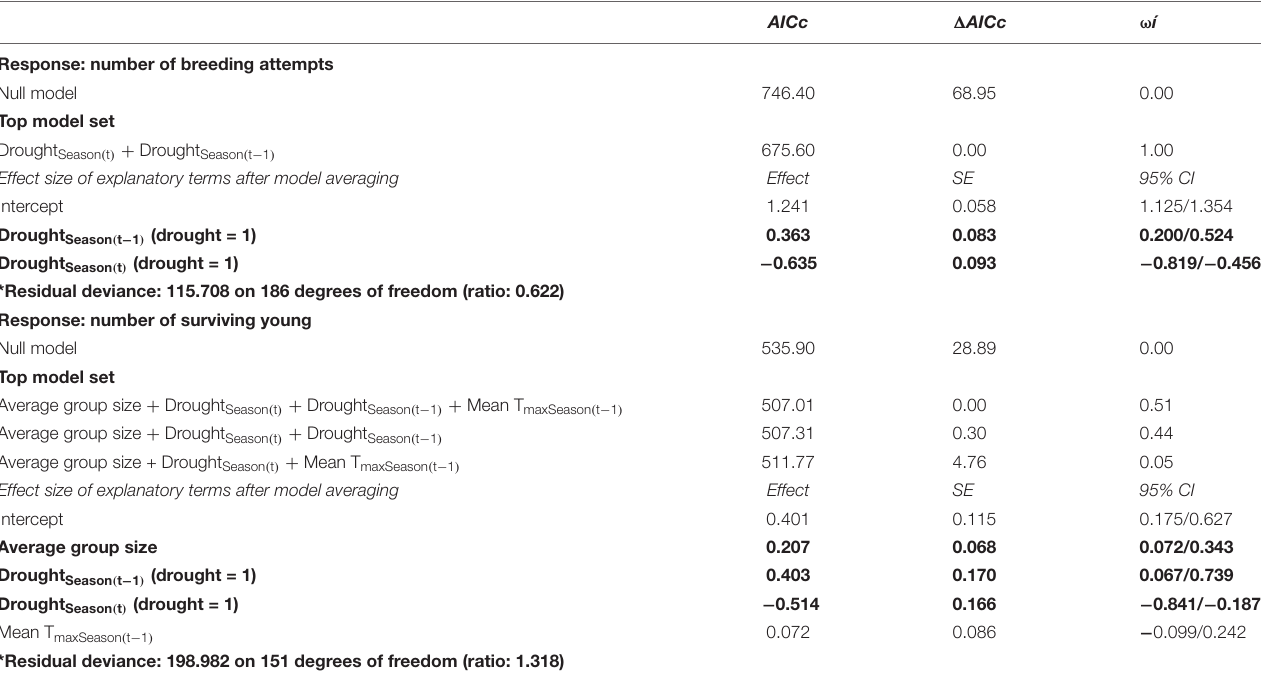
FIGURE 2 | Number of breeding attempts initiated per group per breeding season in relation to (A) the occurrence of drought in a previous breeding season, showing the model-predicted mean (black filled diamond) ± 1.96 × standard error (black whiskers), and (B) the occurrence of drought during the current breeding season. Data points are jittered for improved visibility. TABLE 1 | Top GLMM model sets for analyses on the number of breeding attempts per group per season ( n = 190 group-seasons from 39 groups over 15 breeding seasons) and the number of surviving young per group ( n = 156 group-seasons from 32 groups over 15 breeding